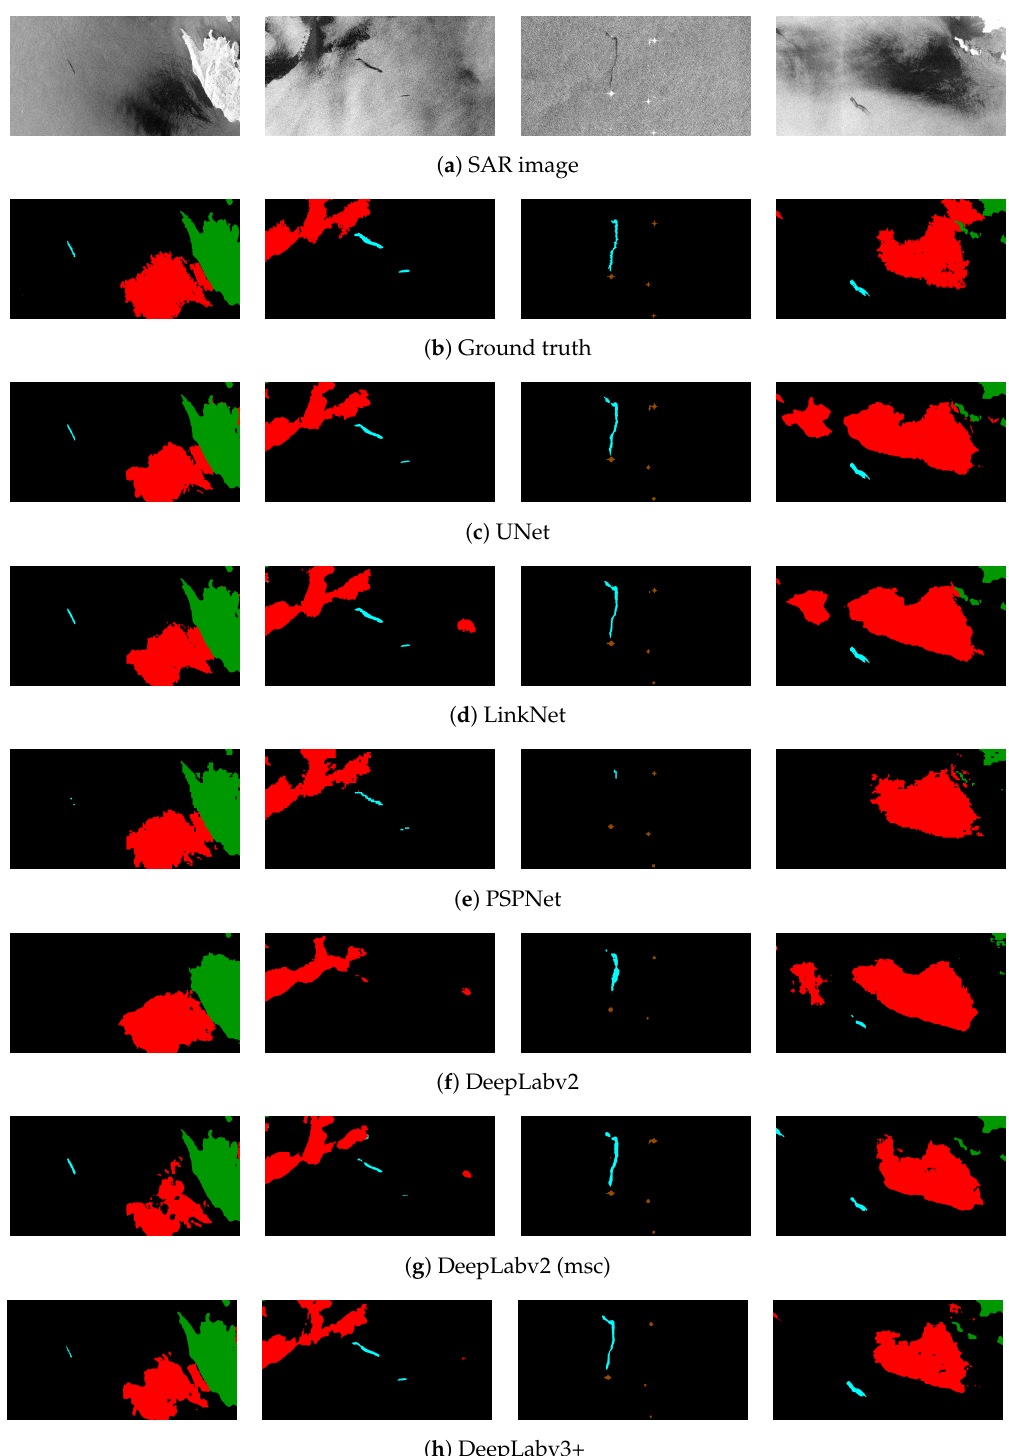
Figure 8. Example 1 of qualitative results of the examined segmentation models on the presented oil spill